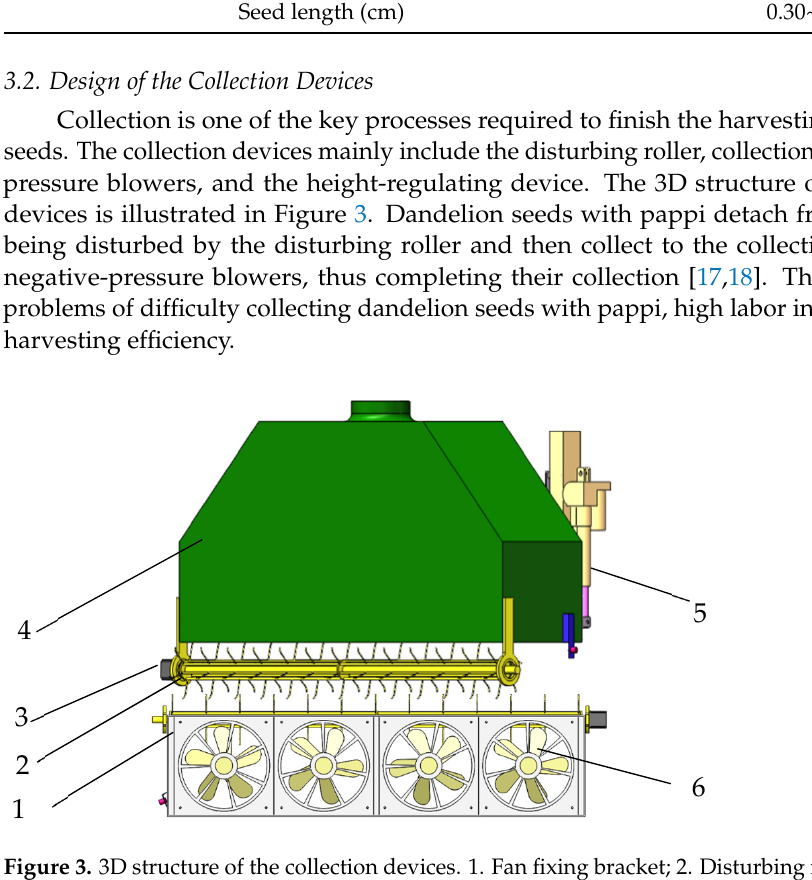
Figure 3. 3D structure of the collection devices. 1. Fan fixing bracket; 2. Disturbing roller; 3. Electrical machine; 4. Collection cover; 5. Height-regulating device; 6. Fan blades.